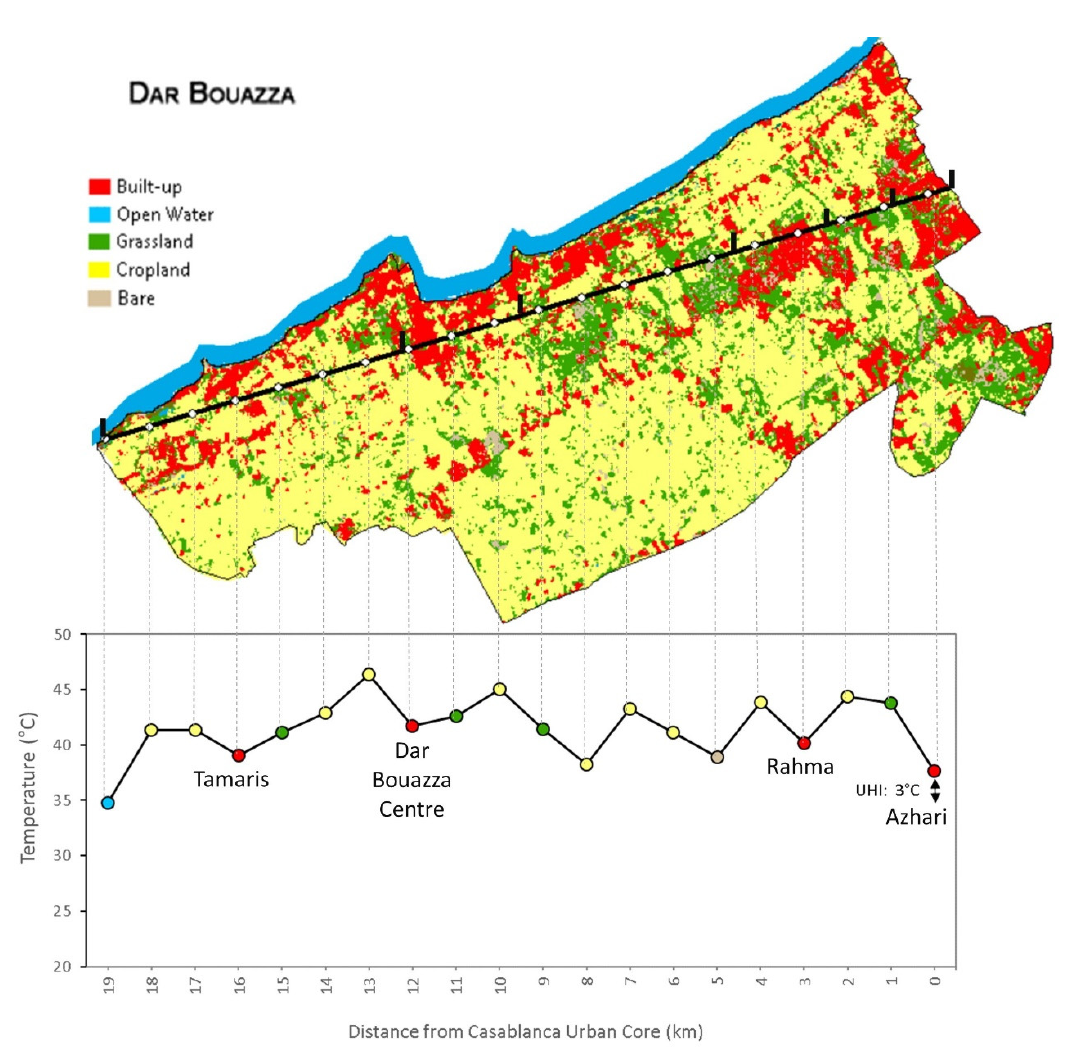
Figure 17. Figure showing transect superimposed on the Dar Bouazza commune landcover (upper panel) and temperature cross-section along the transect and the name of the different neighborhoods/towns (lower panel). It is remarkable that all built areas are cooler than their immediate surroundings (see text for details). The first point to the left of the transect represents a mixed pixel consisting of land and water.